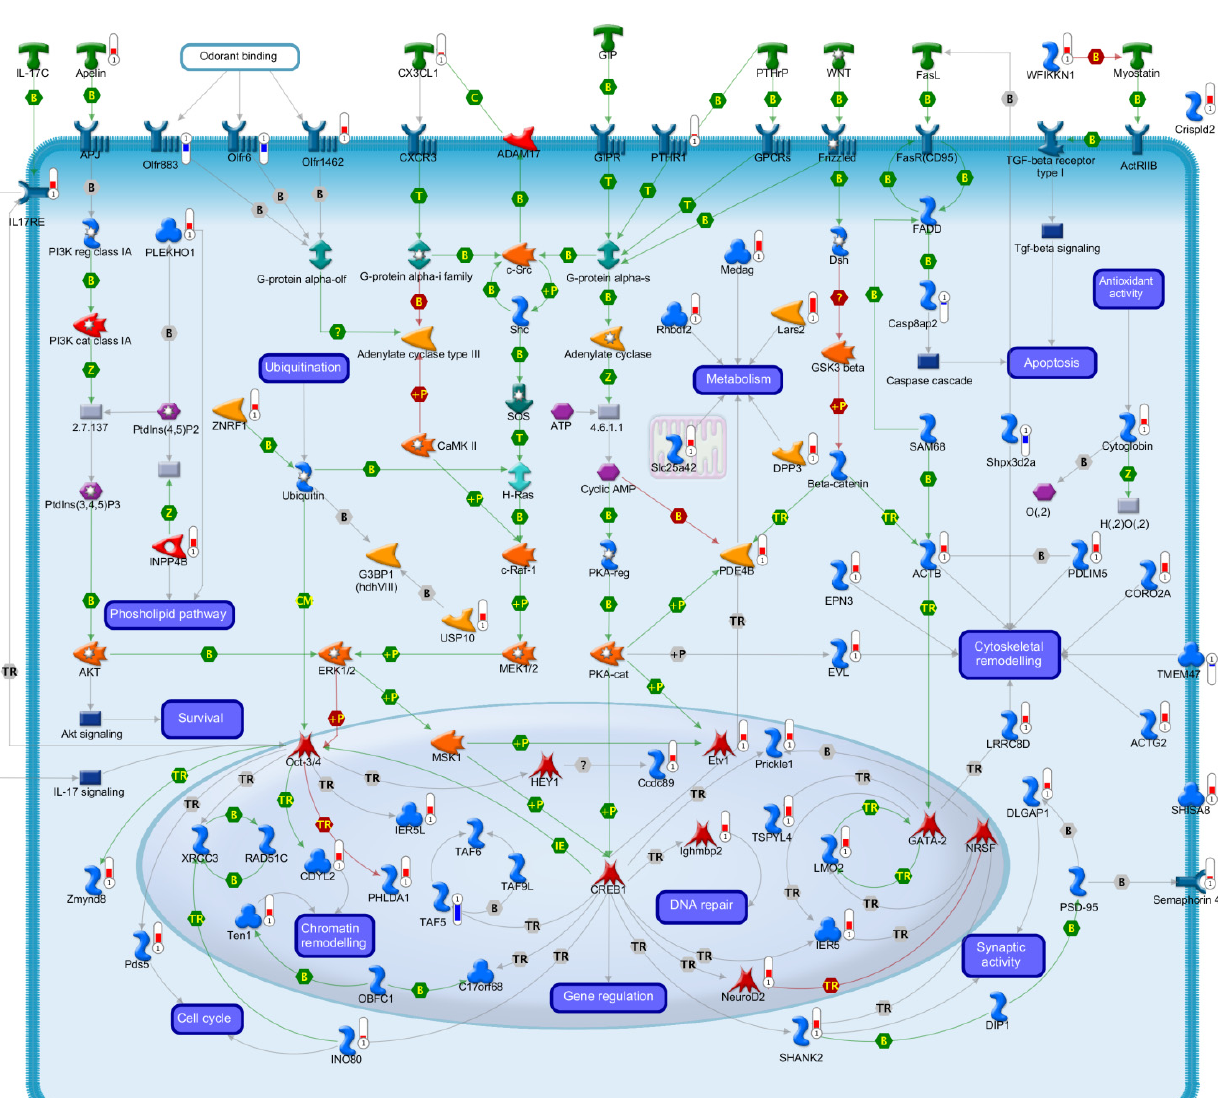
Figure 2. A comprehensive picture showing expression changes associated with CGNs rescue by Gip treatment. Fifty out of sixty-five “Survival related genes” (SGRs) encode proteins with a known function. This figure represents the sub-cellular compartments and molecular processes of these proteins. Each encoded protein is labeled with a thermometer that indicates gene expression changes: downward thermometers have a blue color and indicate down-regulated expression, whereas upward thermometers have a red color and indicate up-regulated expression. In addition to the SRGs, this Figure includes other genes (without a thermometer), which are part of a specific pathway. The figure legend below shows the set of symbols whereby network objects and interactions between objects are indicated in the figure. Mechanism of physical interactions between objects is indicated as follows: ( B ), binding; (+ P ), phosphorylation; ( Z ), catalysis; ( T ), transformation; ( TR ), transcription; ( CM ), covalent modifications; ( IE ), influence on expression; and ( ? ),